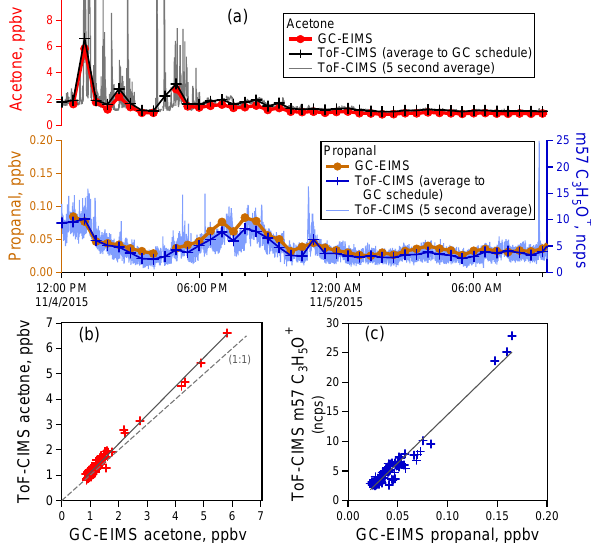
Figure 11. (a) Time series of acetone and propanal measurements from NO + ToF-CIMS and GC-EIMS in ambient air. Measurements shown include the GC-EIMS measurement (5min sample every 30min, circle markers), the NO + ToF-CIMS measurement aver- aged over the 5min GC sampling period (cross markers), and the NO + ToF-CIMS measurement averaged to a 5s running mean. (b) Correlation between NO + ToF-CIMS and GC-EIMS measure- ment of acetone. (c) Correlation between NO + ToF-CIMS and GC- EIMS measurement of propanal.